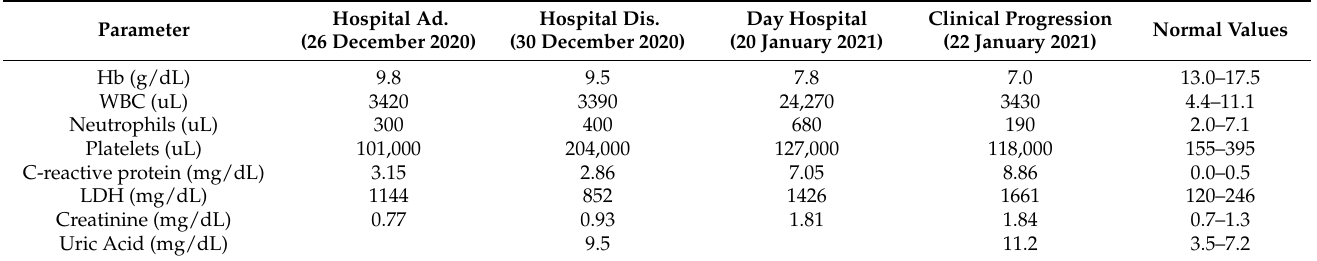
Table 1. Relevant laboratory analysis performed at different timepoints (hospital admission, hospital discharge, day hospital, clinical progression and normal values).